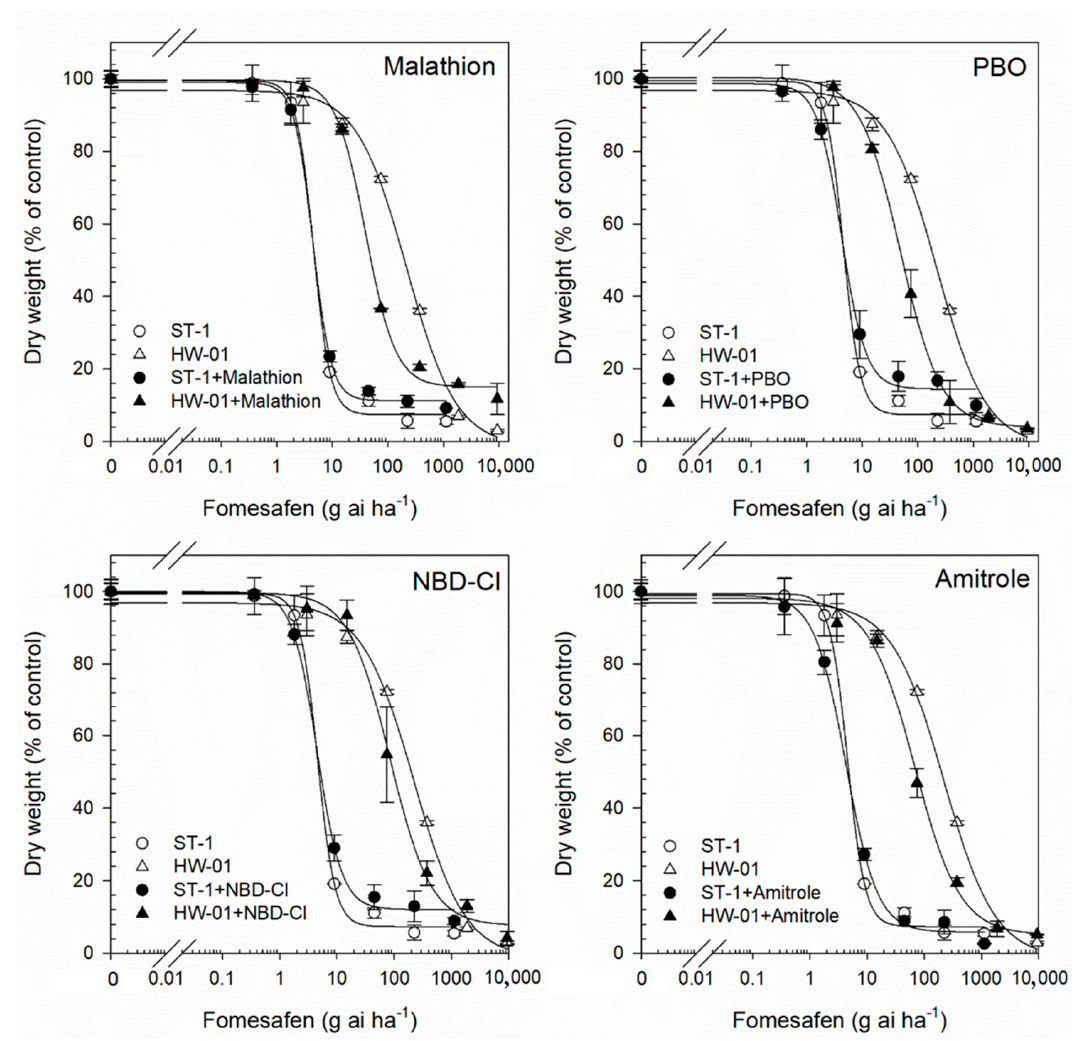
Figure 3. The dose–response curves of the HW-01 population (R) and ST-1 population (S) to